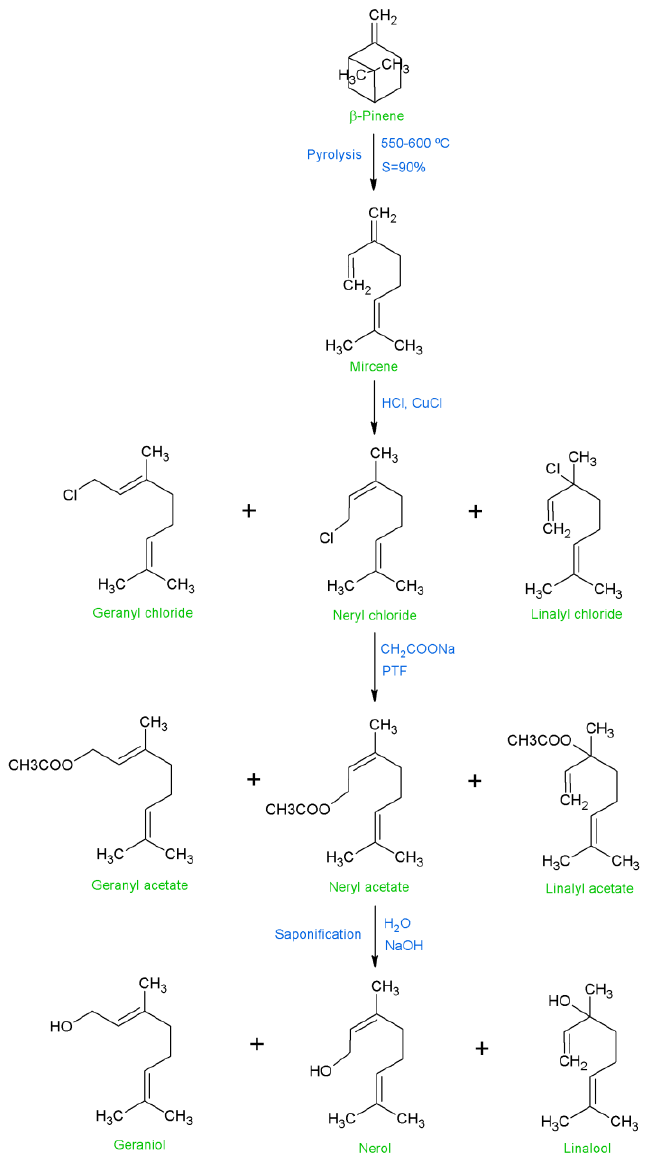
Figure 1. Industrial-scale production process of nerol and geraniol. Powered by International Flavors and Fragrances (IFF), Pinova, and Dérivés Tecnal Résiniques et Terpéniques (DRT). Adapted from